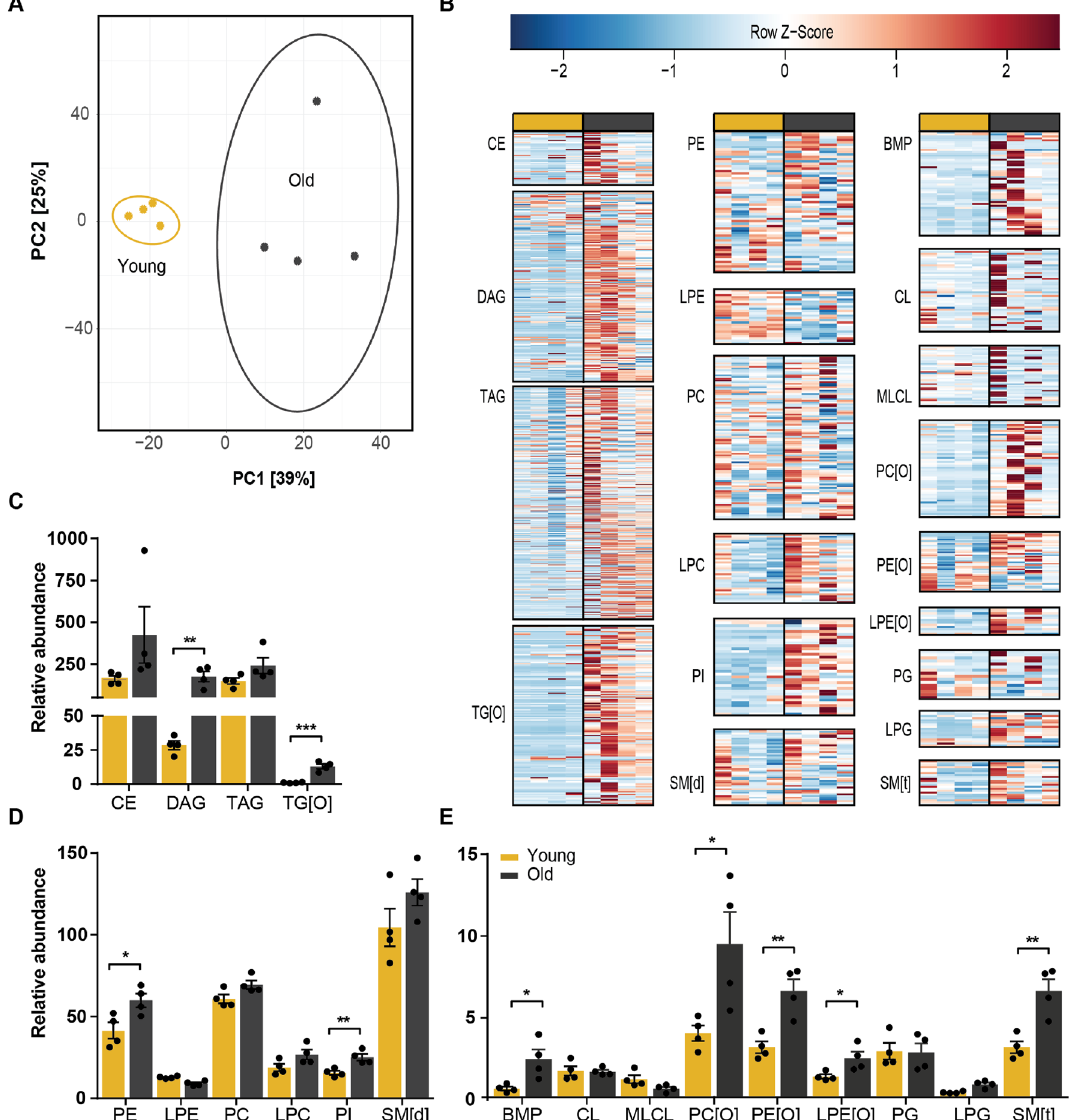
Figure 2. Global accumulation of lipids in aged WAT. ( A ) Principal component analysis of young and aged mice WAT lipidome shows clear separation. ( B ) Heatmaps of all lipid classes arranged from left to right by lipid abundance and ordered from top to bottom by acyl chain length. Relative abundance of ( C ) sterol and glycerolipids; ( D ), ( E ) glycerophospholipids and sphingomyelins show accumulation of almost all lipid classes. *P < 0.05, **P < 0.01, ***P < 0.001 (unpaired Student’s t-test) (n = 4). PCA analysis and heatmaps were created in R programming language (v3.6.3; http://www.r-proje ct.org). Bar graphs were created in Graphpad Prism (v8.3.0; https ://www.graph pad.com/scien tific -softw are/prism /). Figure layout was prepared in Adobe Illustrator CS6 (v16.0.3; https ://www.adobe be found in Supplementary Figure S1). Side-by-side comparison of lipids in young versus aged WAT revealed that the rhythmic lipids peak at different times. For example, TAGs and their alkylated counterpart TG[O] peak early in the dark phase in old WAT, whereas the peak level in young WAT was reached at the end of the dark phase (Fig. 4H,I). This difference was even more pronounced when visualizing at what time point each rhythmic lipid reached their peak level (Fig. 4H,I; see also Supplementary Tables S1 and S2). In young WAT, peak levels were generally scattered during the dark phase. This was especially the case for glycerophospholipids and sphingolipids, which peak at different time points throughout the dark phase. Glycerolipids tended to peak at the end of the dark phase (Fig. 4H). In contrast, the rhythmic glycerolipids in old WAT peaked almost exclusively at the beginning of the dark phase, with some exceptions peaking towards the middle of the dark phase (Fig. 4I). Together, this suggest that with aging the number of rhythmic lipids in WAT are reduced and the peak phases are advanced.